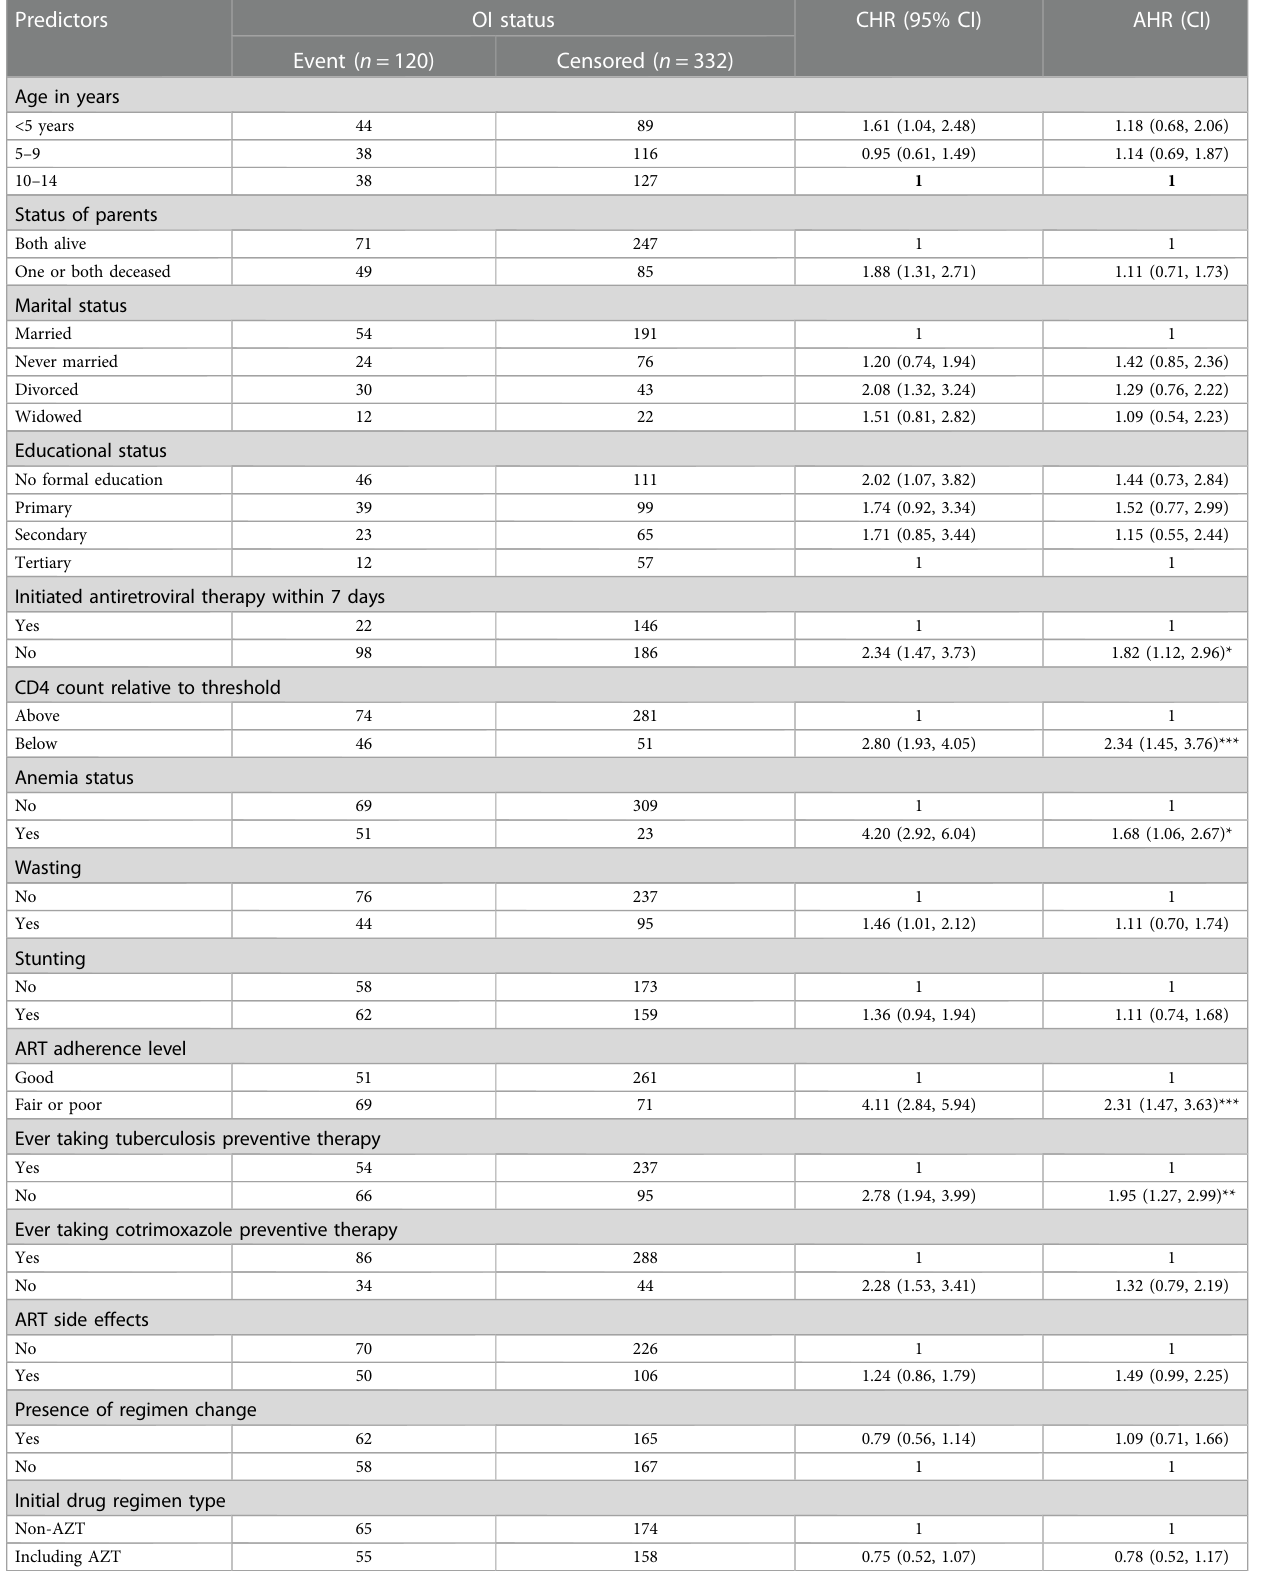
TABLE 7 Bi-variable and multivariable Cox proportional hazard analysis of predictors of incidence of OIs among HIV-infected children receiving ART at Amhara regional state comprehensive specialized hospitals, Ethiopia, 2022 ( n =452).